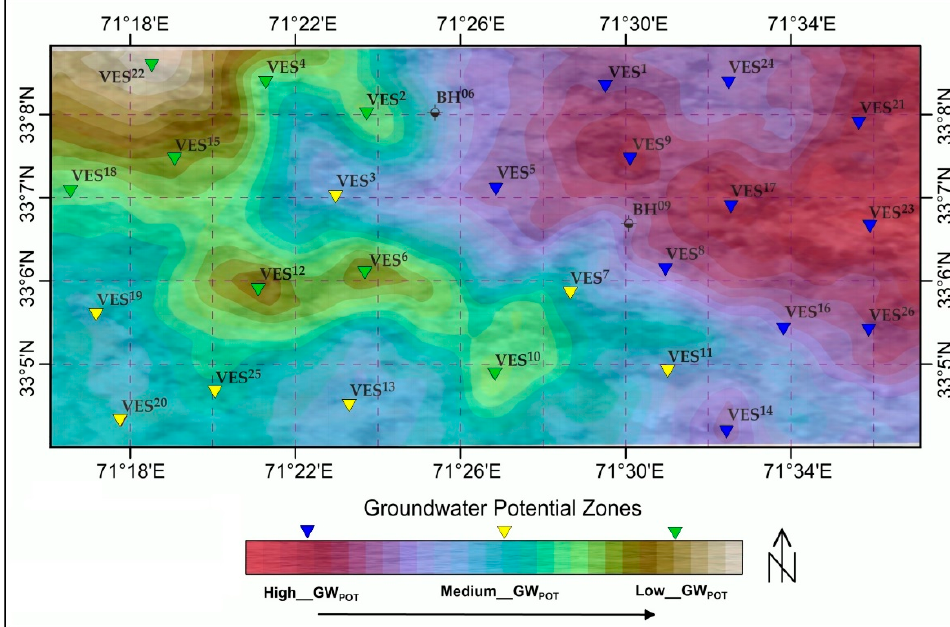
Figure 16. Groundwater potential map of the vertical electrical sounding (VES) surveyed area.